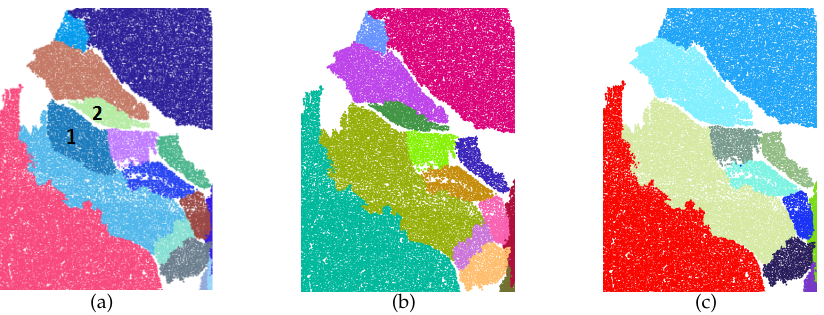
Figure 5. Different precision results obtained by adjusting parameters, where patch1 and patch2 have similar planarity with their neighbors. ( a ) grow ang = 20 ◦ ; ( b ) grow ang = 22 ◦ ; ( c ) grow ang = 23 ◦ .